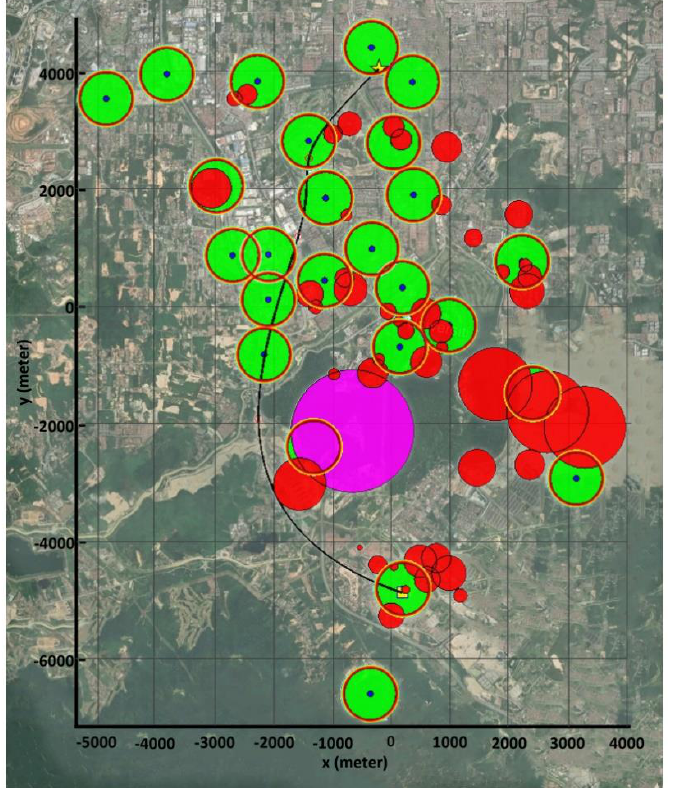
Figure 13. An example of a 3D representation of UAV path planning.